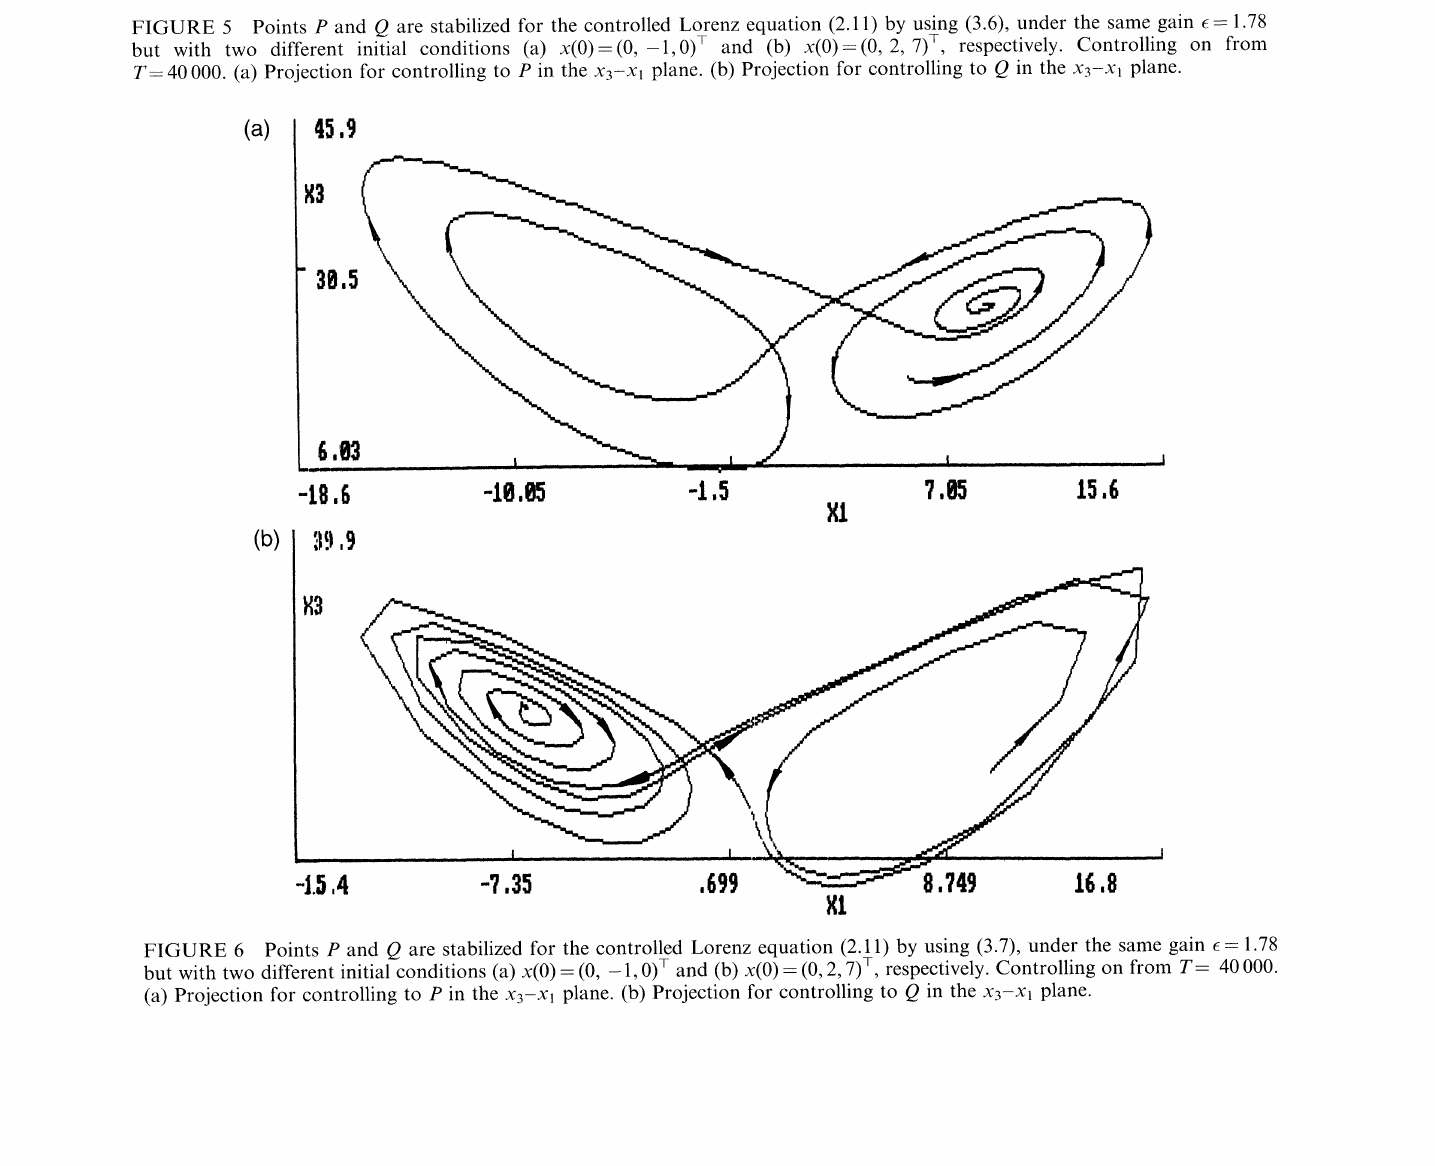
FIGURE 6 Points P and Q are stabilized for the controlled Lorenz equation (2.11) by using (3.7), under the same gain but with two different initial conditions (a) x(0) (0, -1,0) (a) Projection for controlling to P in the x-xl plane. (b) Projection for controlling to Q in the x-xl